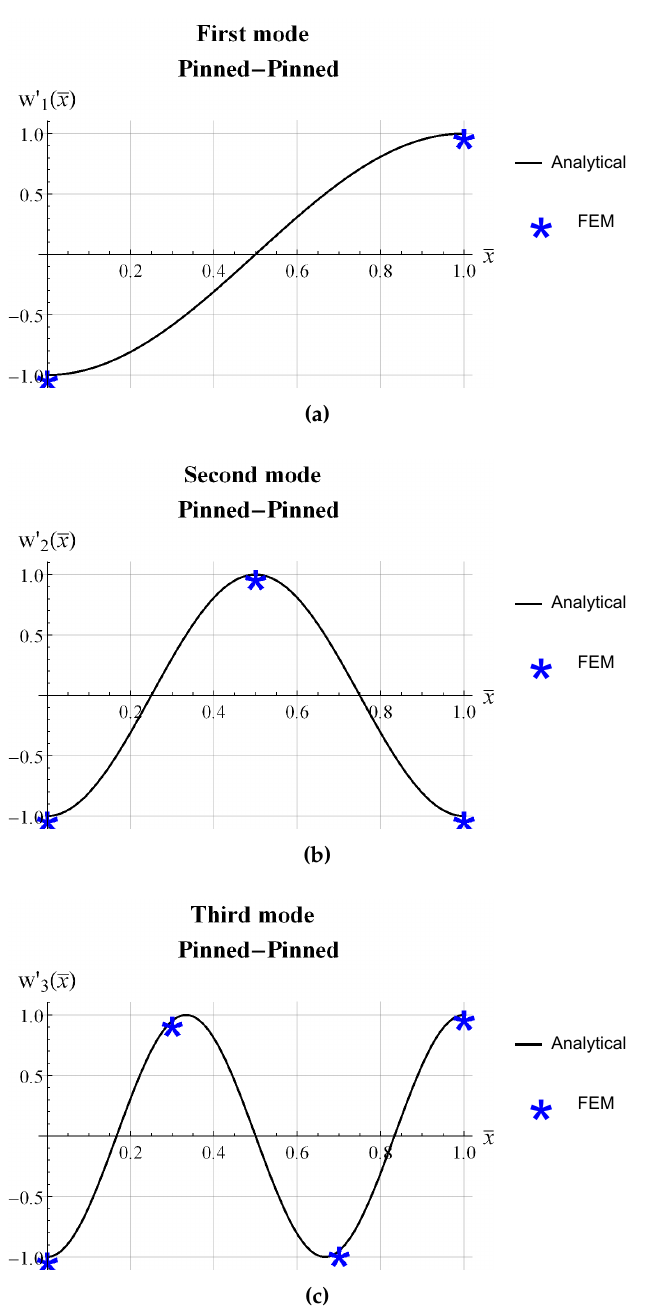
Figure 8. First derivatives of the first three modes for pinned-pinned boundary condition: ( a ) first mode, ( b ) second mode, and ( c ) third mode. The FEM results highlight the optimal location of the voltage sign switch (illustrated with blue